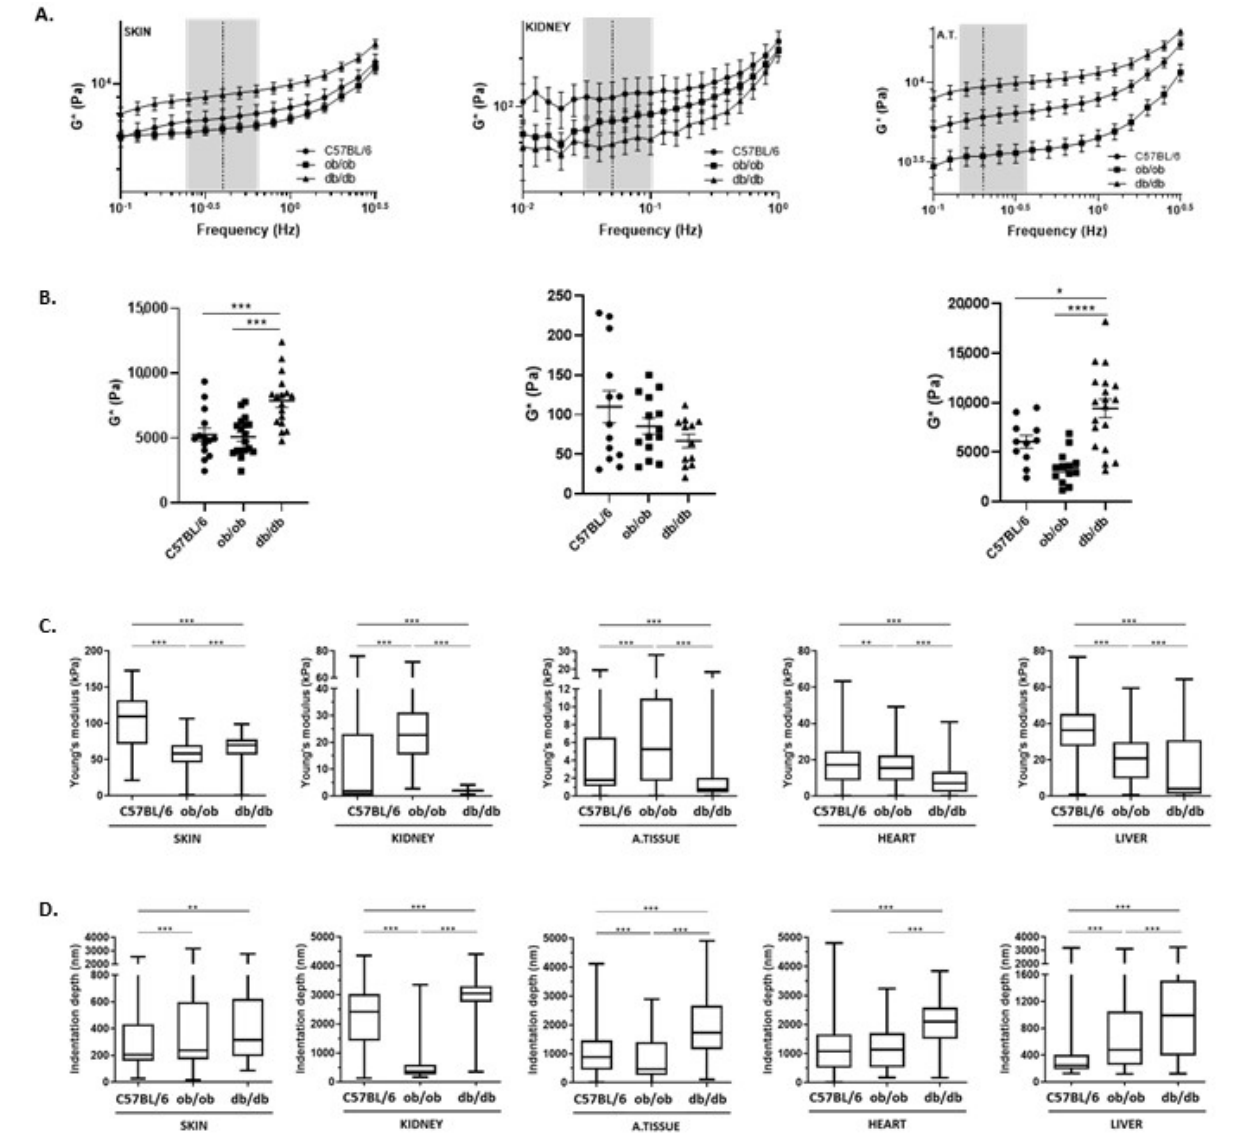
Figure 8. Obese and diabetic mouse tissues present distinct viscoelastic properties. ( A ) Complex shear modulus amplitude (G*) values of the skin, kidney, and adipose tissue matrices obtained at different frequency sweeps, with 0.03%, 0.39%, and 0.04% of shear strain, respectively. Represented are the results from C57BL/6J (circles), ob/ob (squares), and db/db (triangles) animal strains. ( B ) Complex shear modulus of skin, kidney, and adipose tissue scaffolds assessed from the linear viscoelastic region (LVR, gray area) of the performed frequency sweeps (dotted line) represented in a scatter dot plot. Each reading is the average from five animals: C57BL/6J (circles), ob/ob (squares), and db/db (triangles) strains (3 to 4 matrices each) ± SEM. Statistical analyses were assessed using one-way ANOVA * p < 0.05; *** p ≤ 0.001; **** p ≤ 0.0001. ( C ) Atomic force microscopy of skin, kidney, fat, heart, and liver matrices from C57BL/6J, ob/ob, and db/db mice. Represented is the Young’s modulus and ( D ) indentation depth extracted from acquired AFM force indentation curves, after applying the Hertzian model. Statistical evaluation was performed using one-way ANOVA with the Bonferroni Correction Test, ** p ≤ 0.001 and *** p ≤